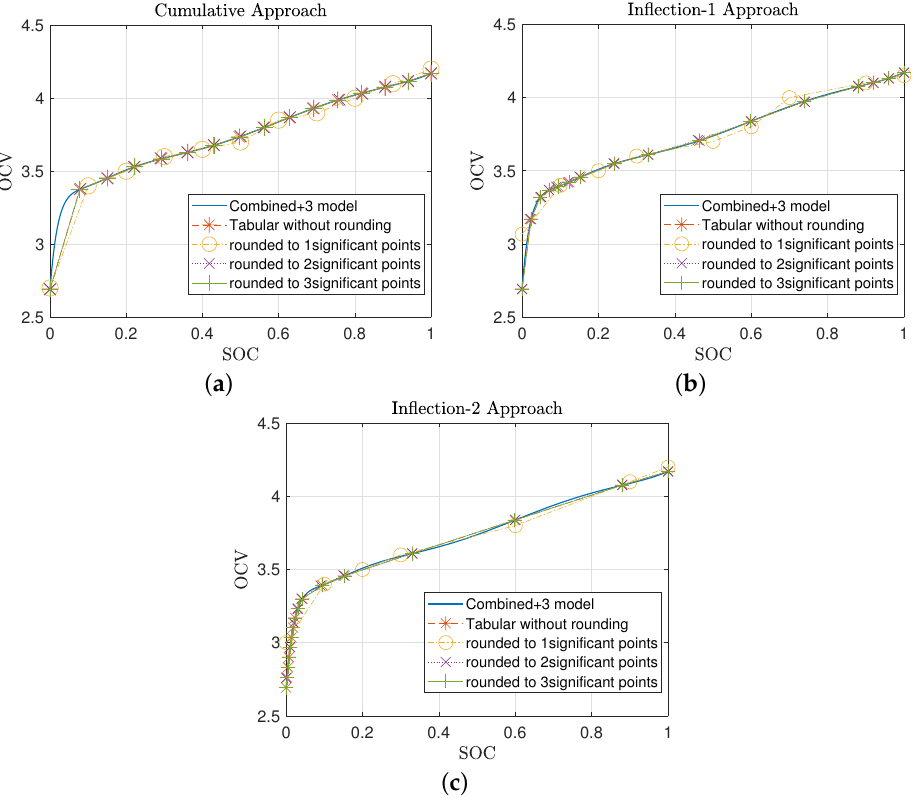
Figure 16. Effect of rounding in tabular models—( a ) cumulative, ( b ) inflection-1,and ( c ) Inflection-2.